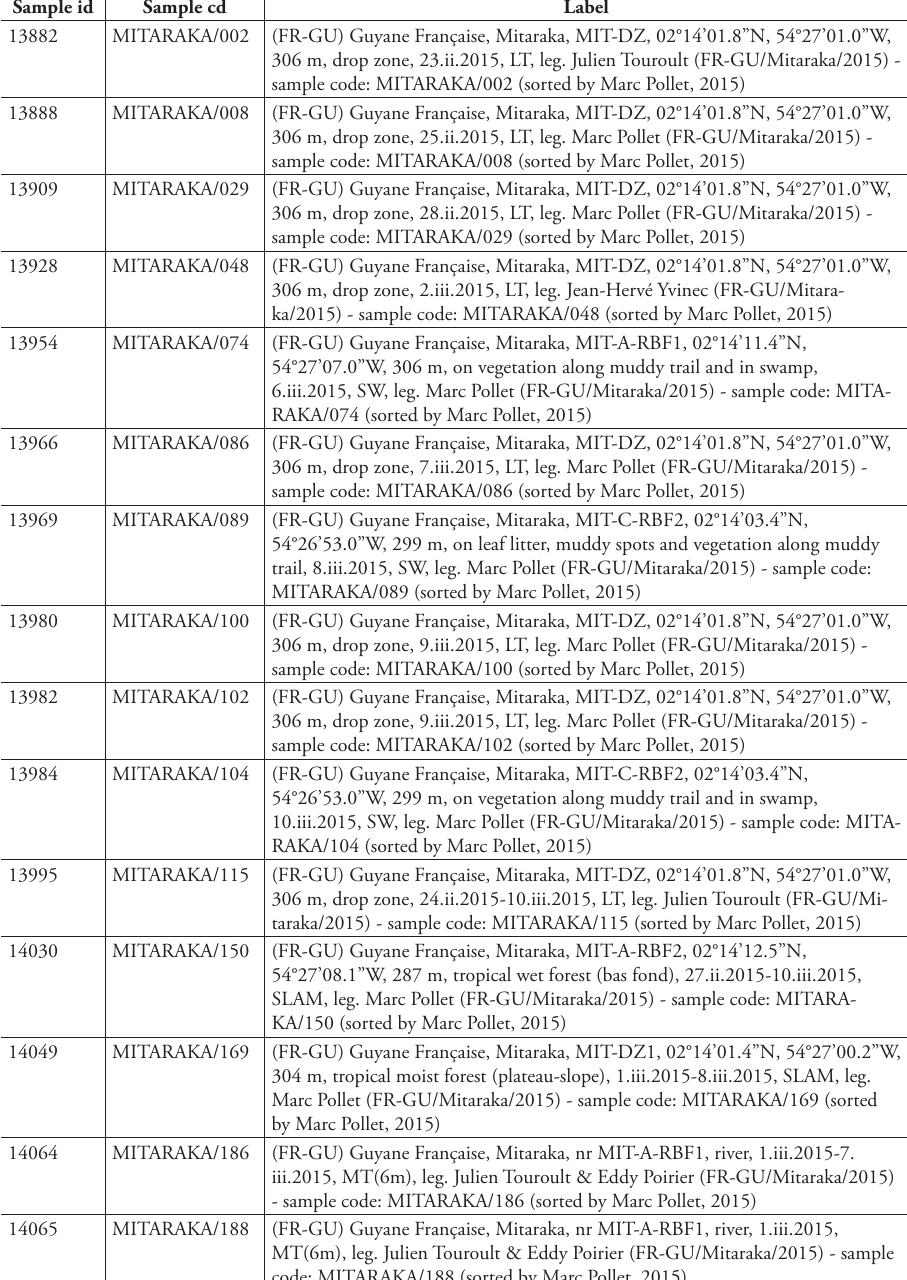
Table 1A. See Legend of Table 1 for explanation of abbreviations for collecting